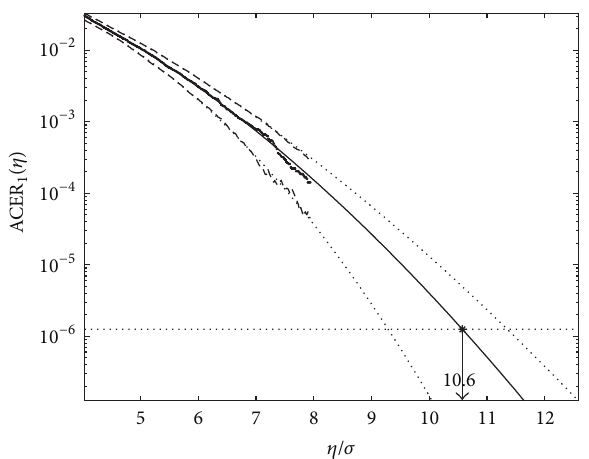
Figure 10: Hekkingen wind speed statistics, 14 years hourly data. ̂𝜀 (𝜂) ( ∗ ); optimized curve fit (—); empirical 95% confidence band 1 (--); optimized confidence band ( ⋅⋅⋅ ). Tail marker 𝜂 1 = 23 m / s = 4.02𝜎 ( 𝜎 = 5.72 m / s).